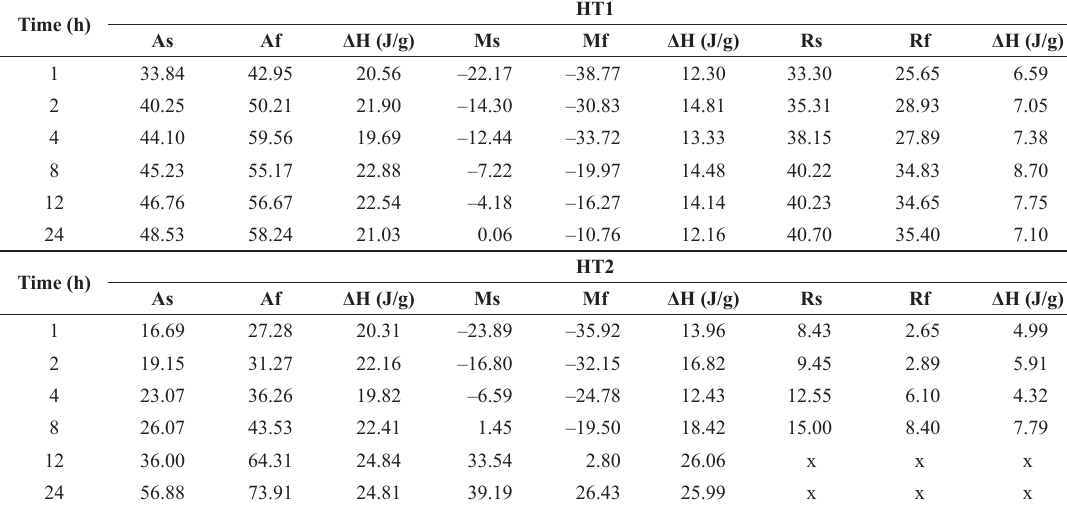
Table 1. Summary of results of the calorimetric properties of the samples treated at 400 °C and 500